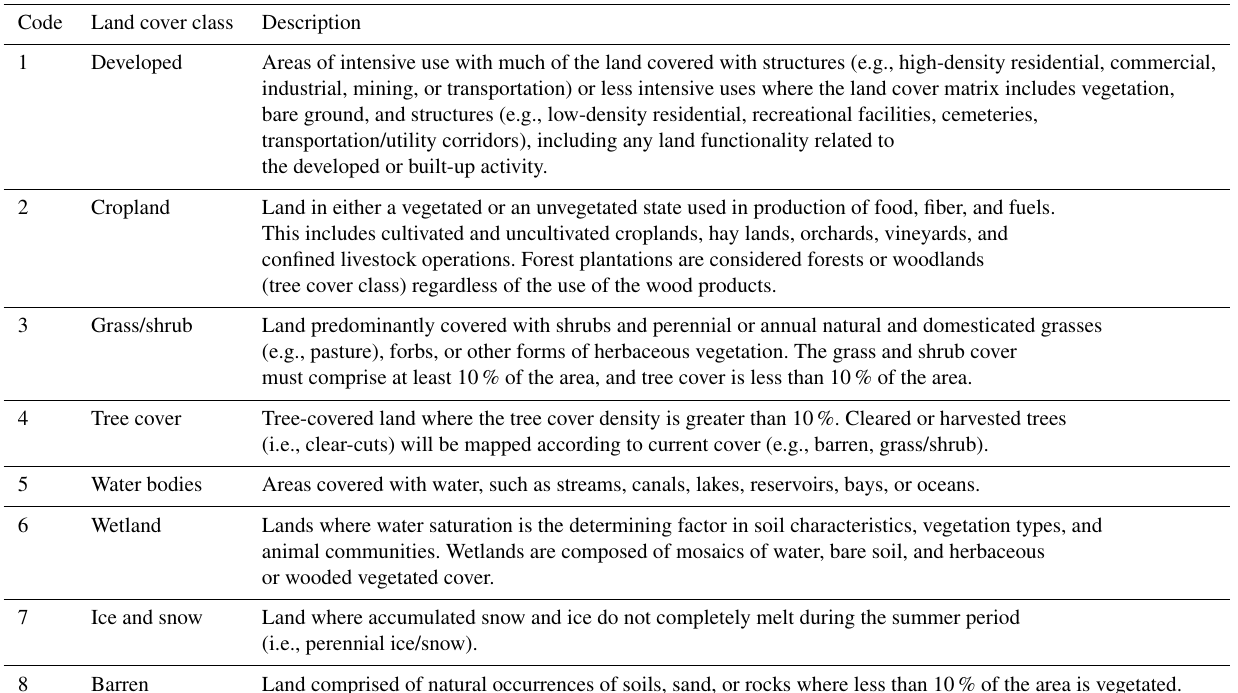
Table 1. LCMAP land cover product